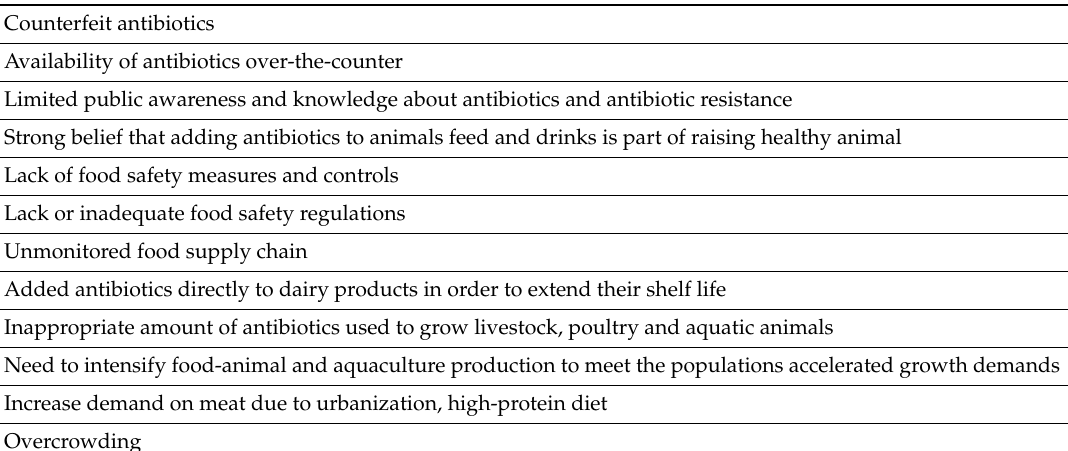
Table 1. Socio-economic drivers and inadequate socio-ecological behaviors in